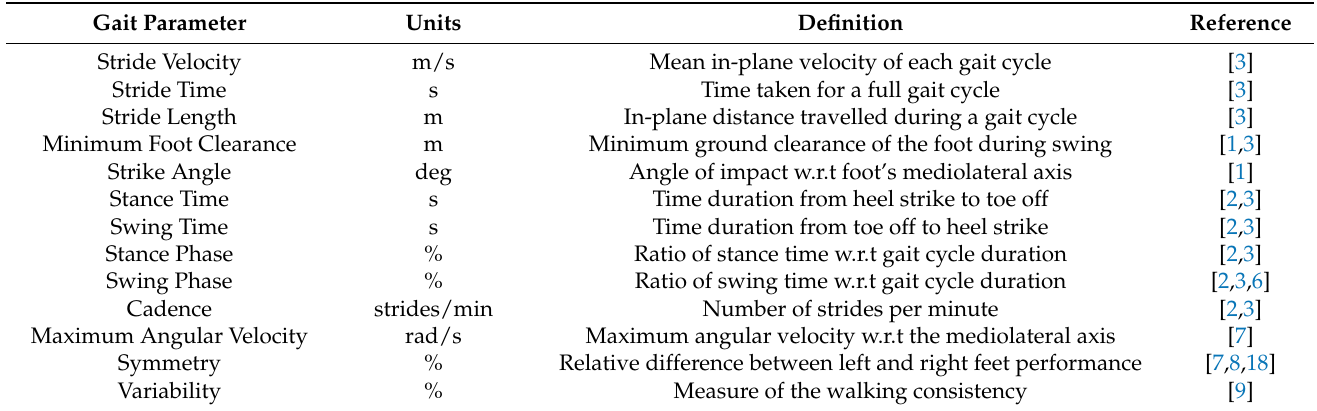
Table 1. List of gait parameters measured and estimated by the Nushu